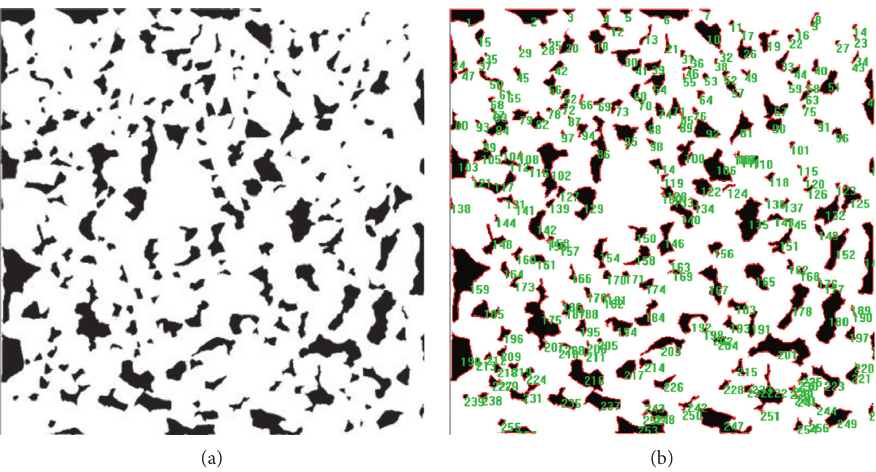
Figure 4: Planar pores extraction from cut section image: (a) binarized image; (b) pores feature parameters extraction.